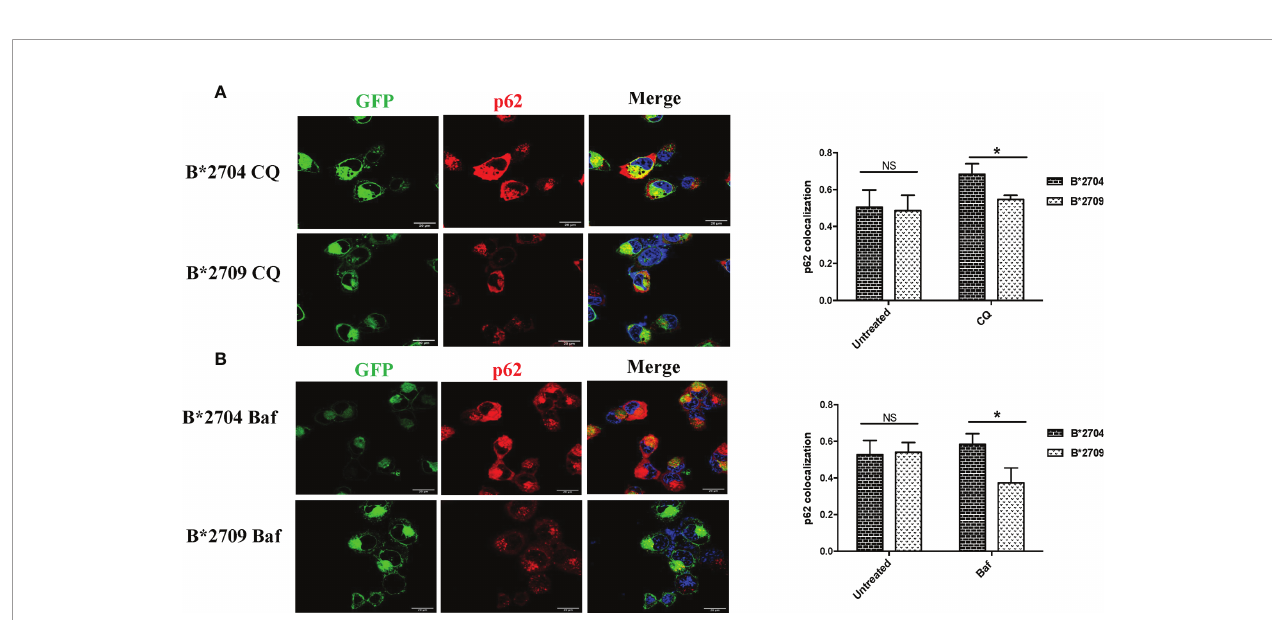
FIGURE 5 | Cells transfected with GFP fusion constructs of the disease-associated, B*2704, and non-disease-associated, B*2709, subtypes were treated with chloroquine (CQ) (A) and ba fi lomycin (Baf) (B) . Immuno fl uorescence staining was performed under confocal microscopy using anti-p62 antibody (probed with anti-rabbit Alexa Fluor 568) (red). Nuclear staining was done using DAPI (blue). Scale bar, 20 m m. GFP, green fl uorescent protein. NS, non signi fi cant (p > 0.05); *p <